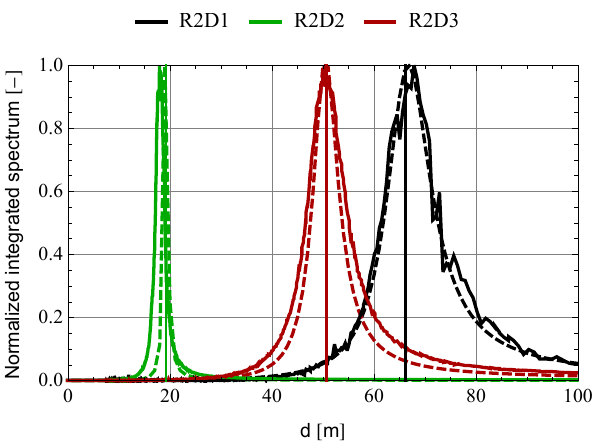
Figure 8. Integrated spectrum versus focus distances for SR1 (R2D1, black line), SR2 (R2D2, green line) and SR3 (R2D3, red